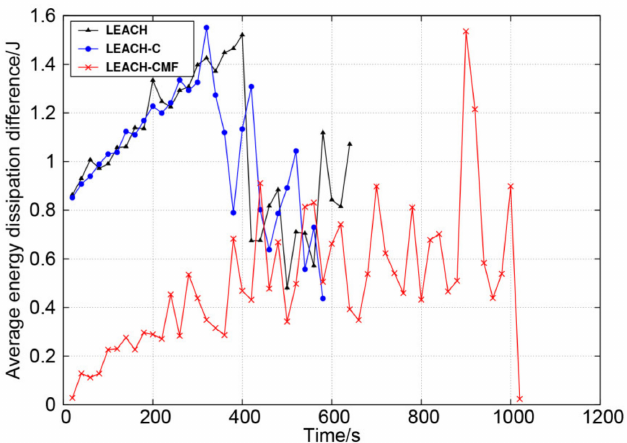
Figure 12. The difference of average energy dissipation per round between cluster heads and non-cluster